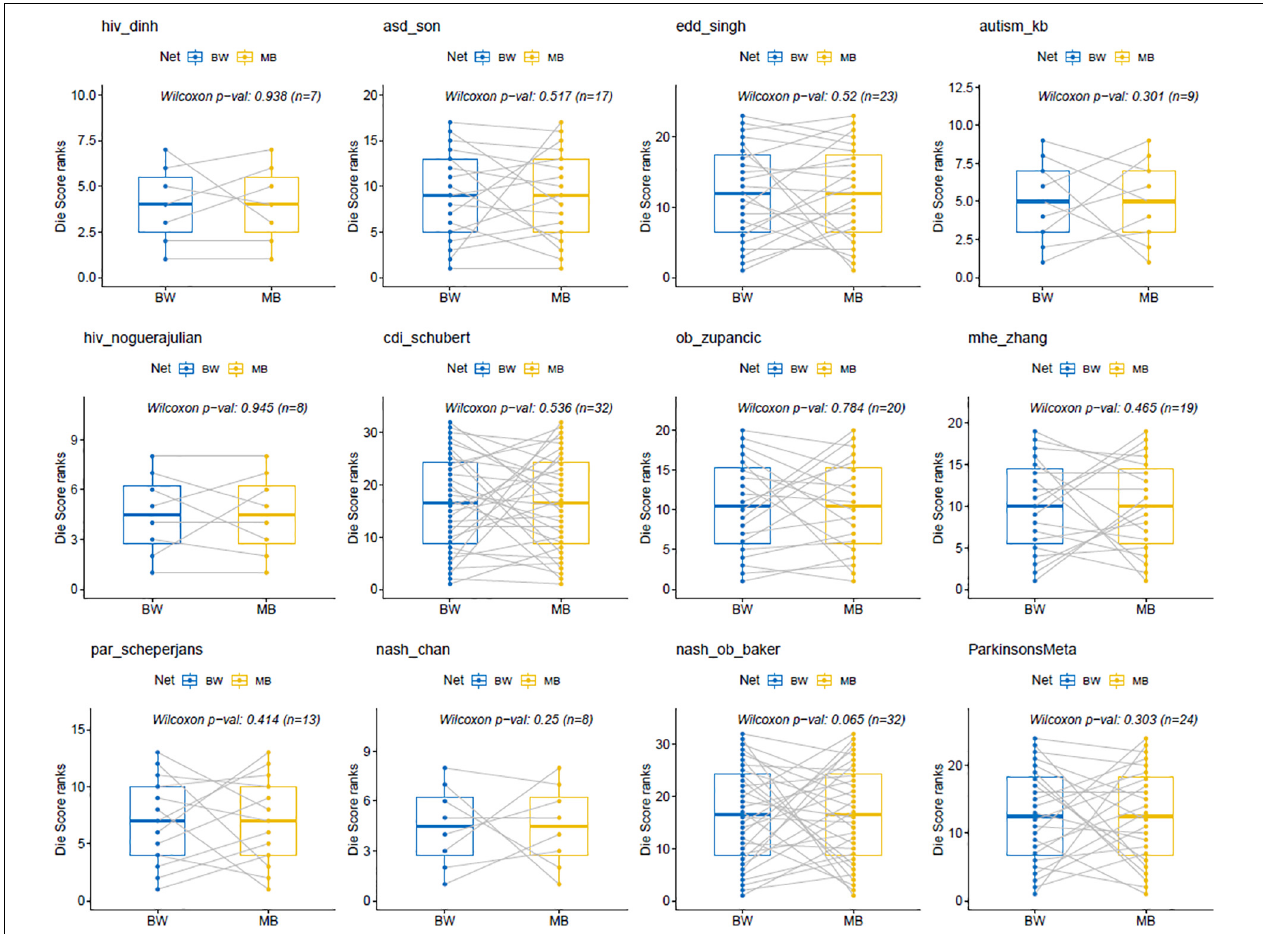
FIGURE 5 | Wilcoxon signed-rank test for BW and MB networks. The p -values are all > 0.05, indicating that the results obtained from the Wilcoxon tests using the ranked Die scores were not statistically significant between the BW and MB networks. This is in favor of the putative AMP defense hypothesis that would expect similar distributions for both types of Die score